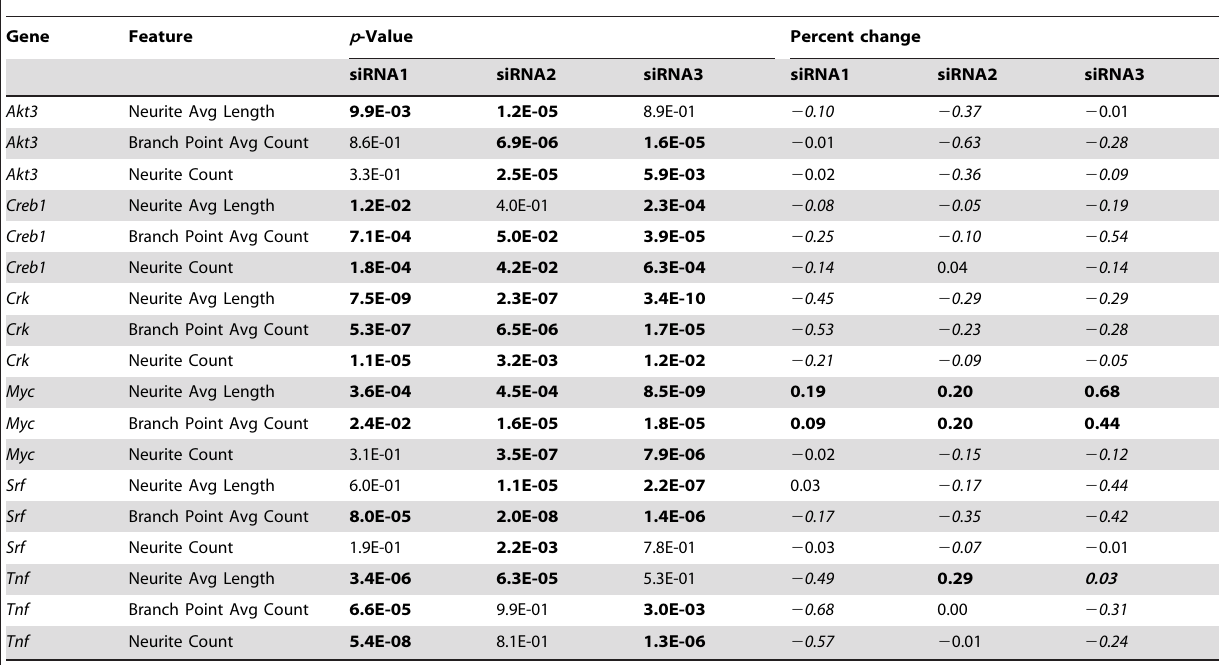
Table 2. Selected genes targeted by siRNAs during differentiation of Neuro2a cells.